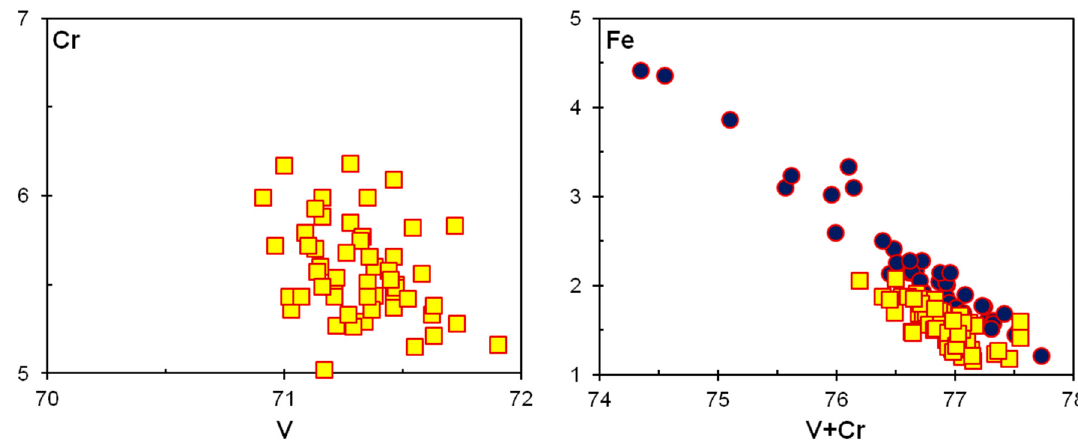
Figure 9. Chemical variations (in wt. %) for uakitite and carlsbergite from the Uakit meteorite. Symbols: squares—uakitite; circles—carlsbergite.